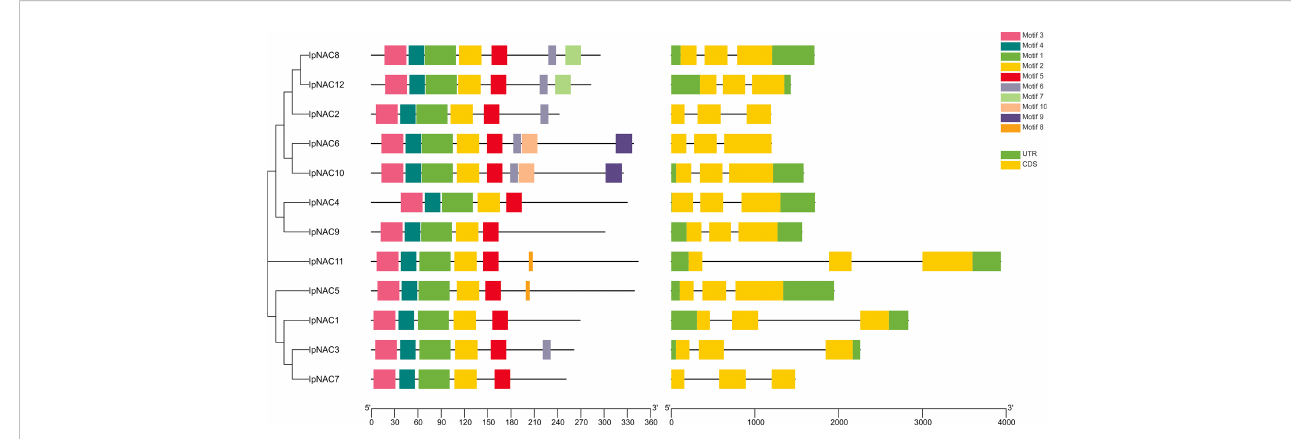
FIGURE 1 Analysis of the conserved motifs and gene structures of Ipomoea pes-caprae IpNAC genes. The conservative motif distribution and homologous tree of IpNACs are located on the left side, which is expressed by a color box. The black scale lines represent the relative protein length. The gene structure is on the right side, the exon and intron are represented by a yellow rectangle and black line, respectively, and the untranslated region (UTR) is represented by a green rectangle. Gene size can be expressed by the scale.